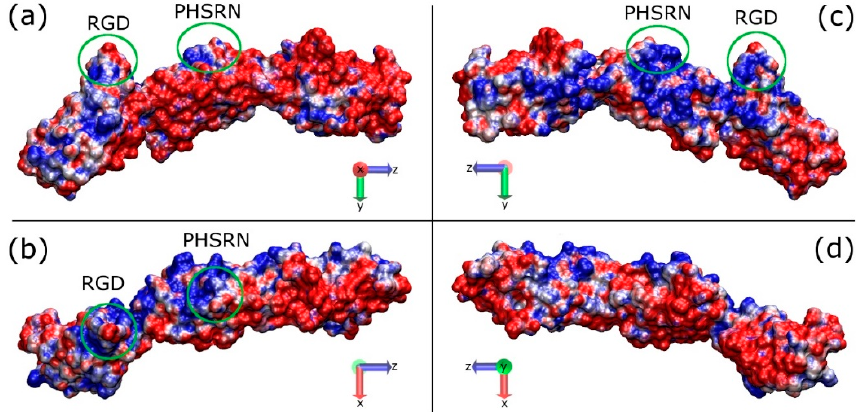
Figure 2. Graphical representations of the FNIII 8–10 domain showing the electrostatic properties (APBS) along the long axis of the protein; ( a , c ) the two sides of the protein on the y-z plane, ( b , d ) the two sides of the protein on the x-z plane. The sides from a to d are referred to as FNa, FNb, FNc, and FNd, respectively. The areas in the green circles indicate the RGD and PHSRN sites, which are facing up in ( a ) and ( c ), pointing out from the page in ( b ), and into the page in ( d ). Red and blue indicate the negatively and positively charged domains, respectively.